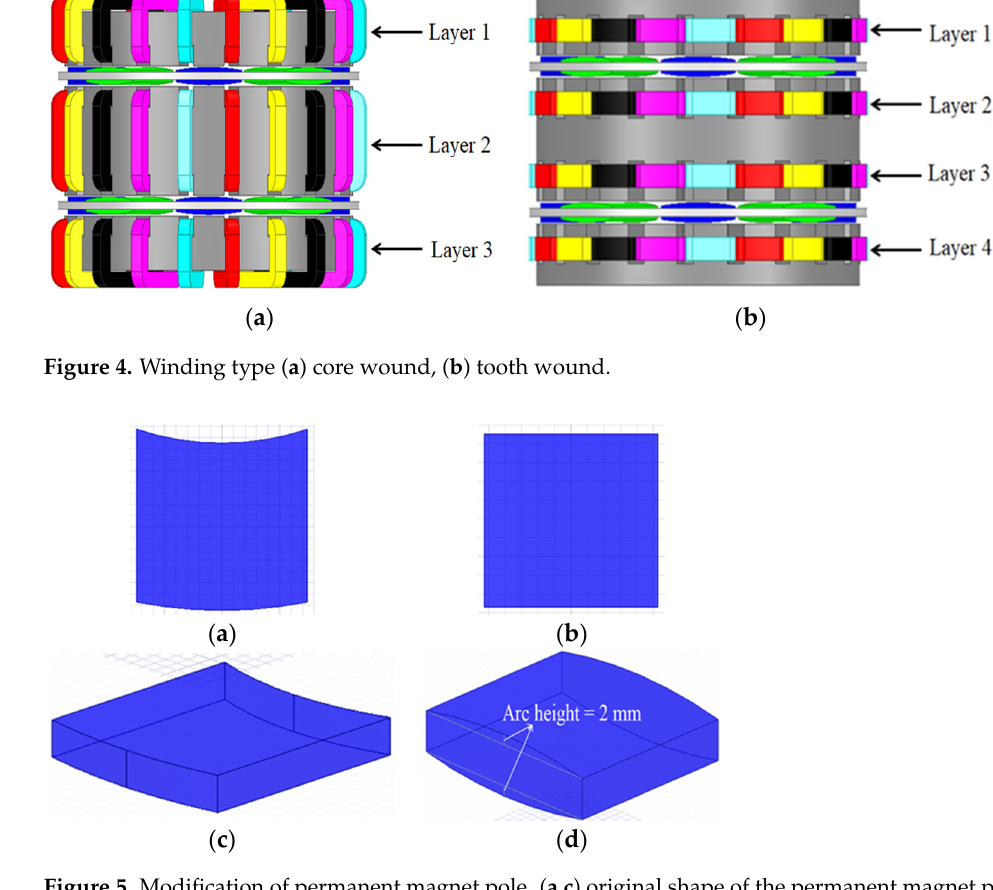
Figure 5. Modification of permanent magnet pole. ( a , c ) original shape of the permanent magnet pole, ( b , d ) modified shape of the permanent magnet pole.